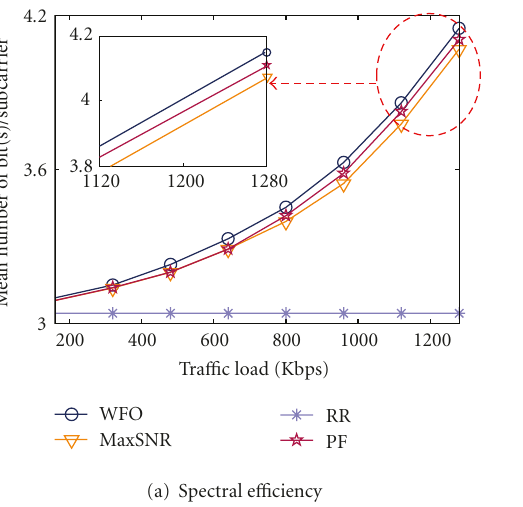
Figure 11: Bandwidth usage e ffi